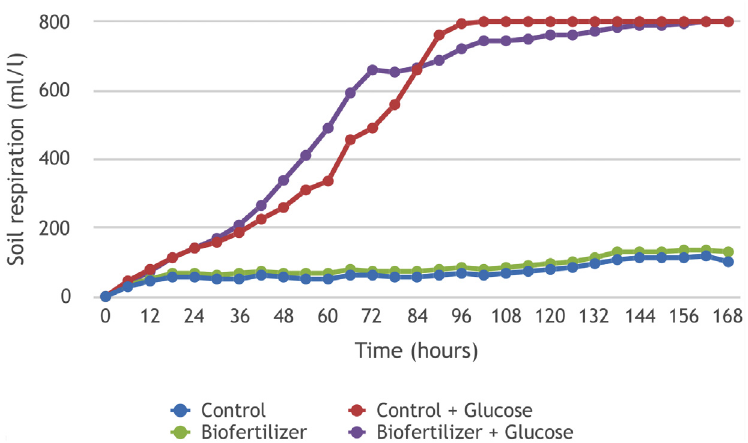
Figure 1. Differences in CO production of treated and control soil samples. The induced method was carried out so that the difference 2 between the results of control and the treated soil samples could become detectable sooner. Glucose was applied as inducer. As expected the CO values increase or 2